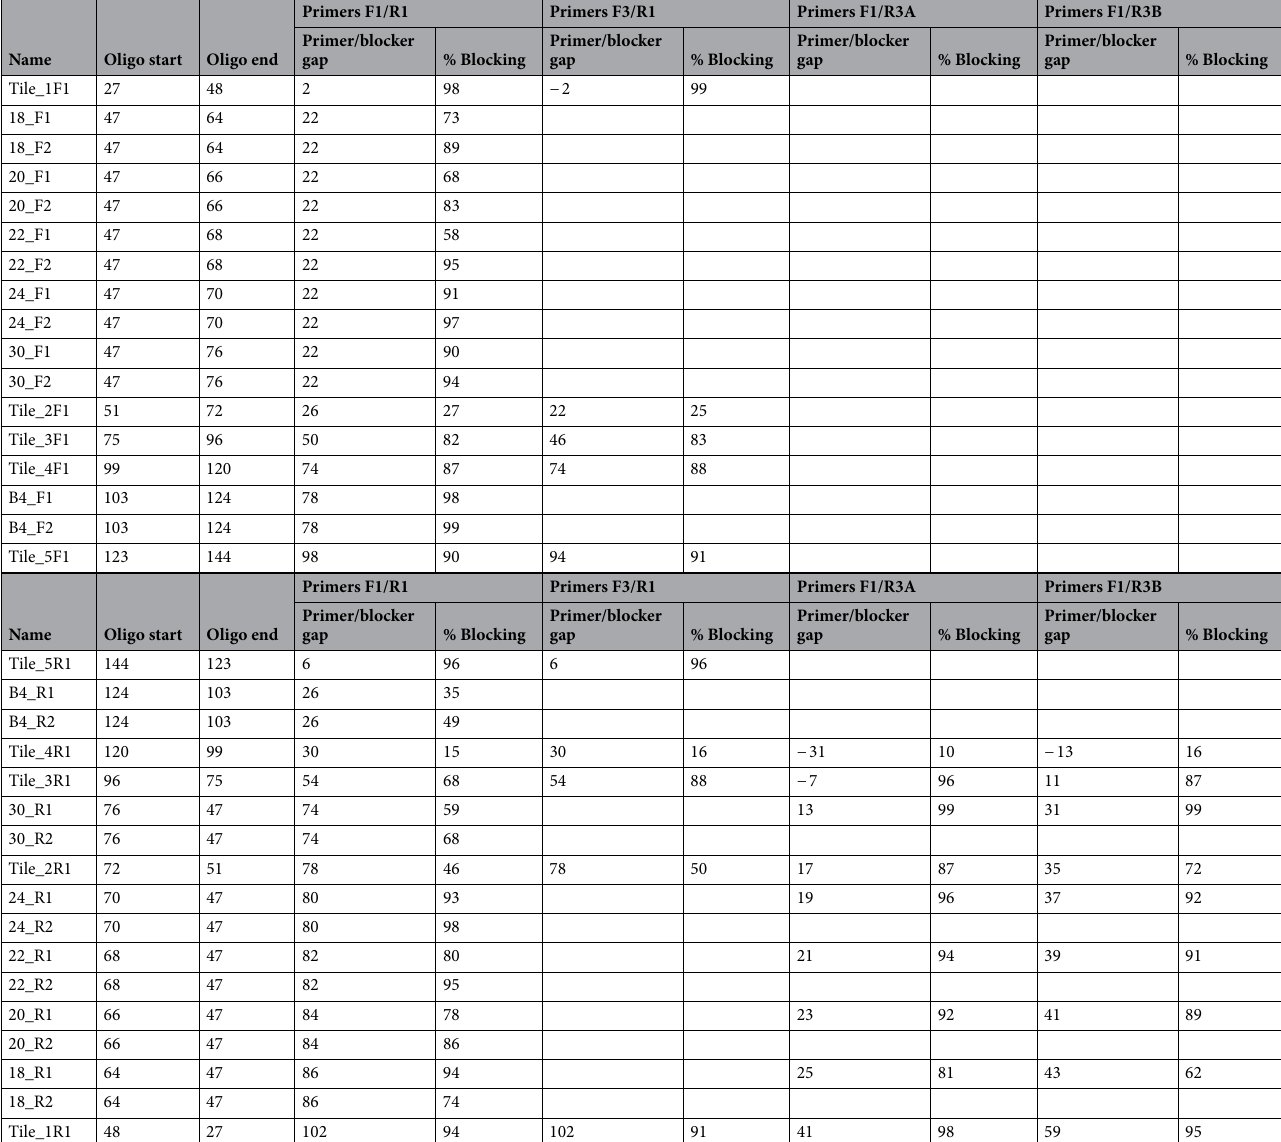
Table 2. Blocking efficiency. Positions of LNA blockers versus Template_0 are listed. More detailed information on each blocker can be found in Table S1. Four sets of primers (shown in Fig. 2) were used with Template_0 and the indicated blockers added at 1 µM. The length of the gap between the elongating primer and the blocker is shown, as well as the efficiency of blocking for each primer set. Blockers identical to the top strand (F) are in the top half of the table, and blockers identical to the bottom strand (R) are in the bottom half of the